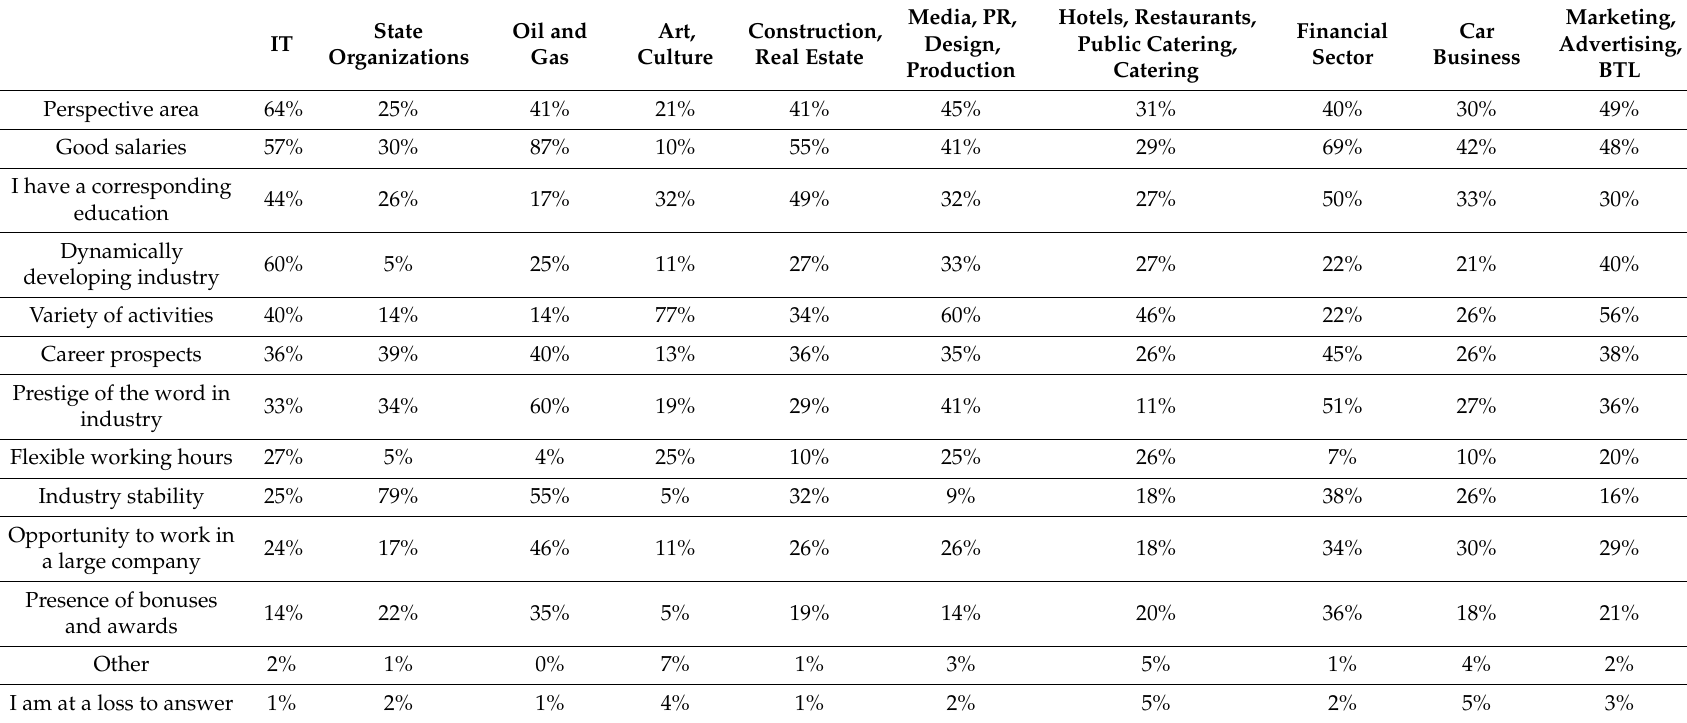
Table 1. Reasons why industries are attractive to applicants (Almanac HeadHunter